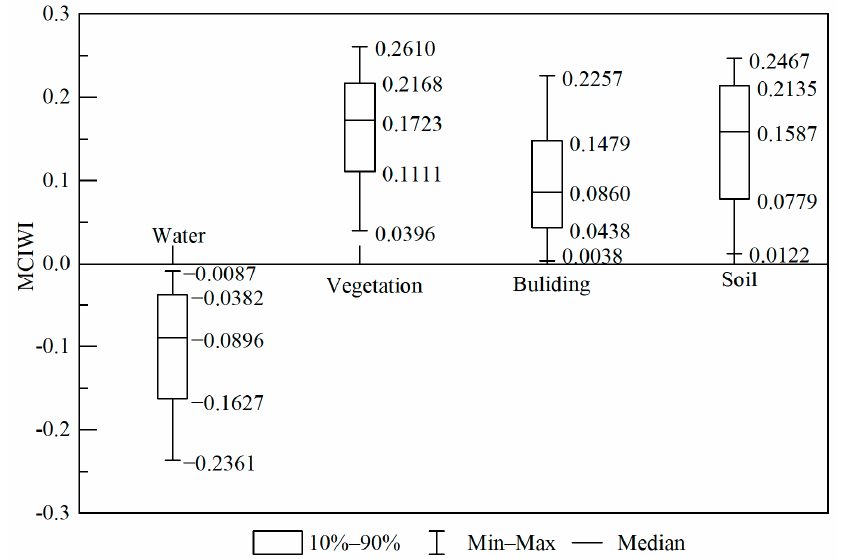
Figure 5. Comparison of MCIWI values of water body and non-water-body information in the study area.